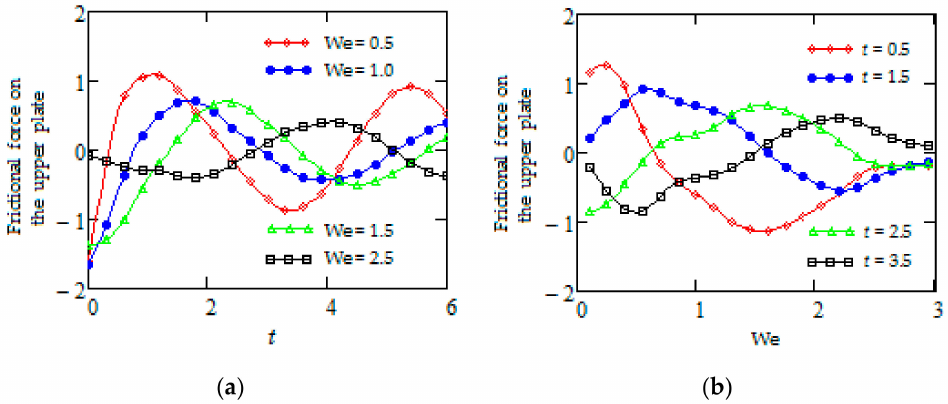
Figure 6. The profiles of the frictional force τ c ( 1, t ) on the upper plate ( a ) versus time t, and ( b ) versus Weissenberg number